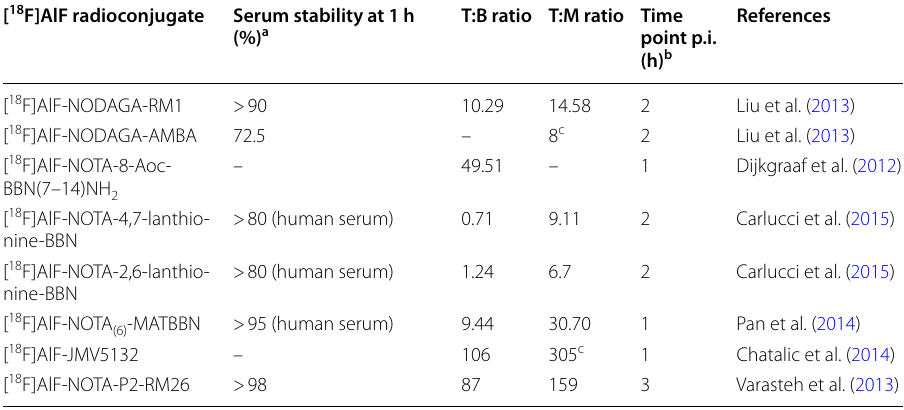
Table 6 A summary of GRPR targeted radiopharmaceuticals and their serum stabilities, tumour-to- blood (T:B) and tumour-to-muscle (T:M) ratios at a given time point